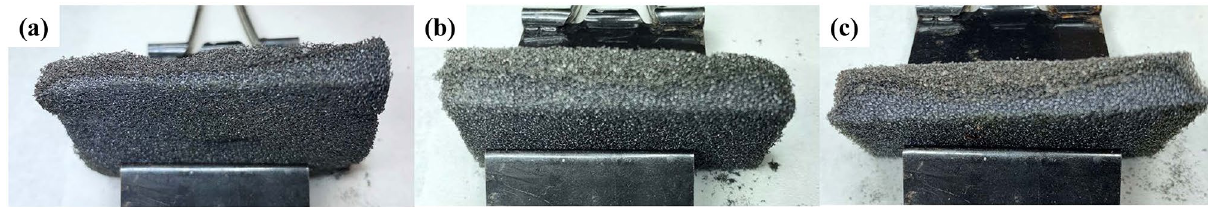
Table 1. UL-94 horizontal burning test results of all the PUFs.